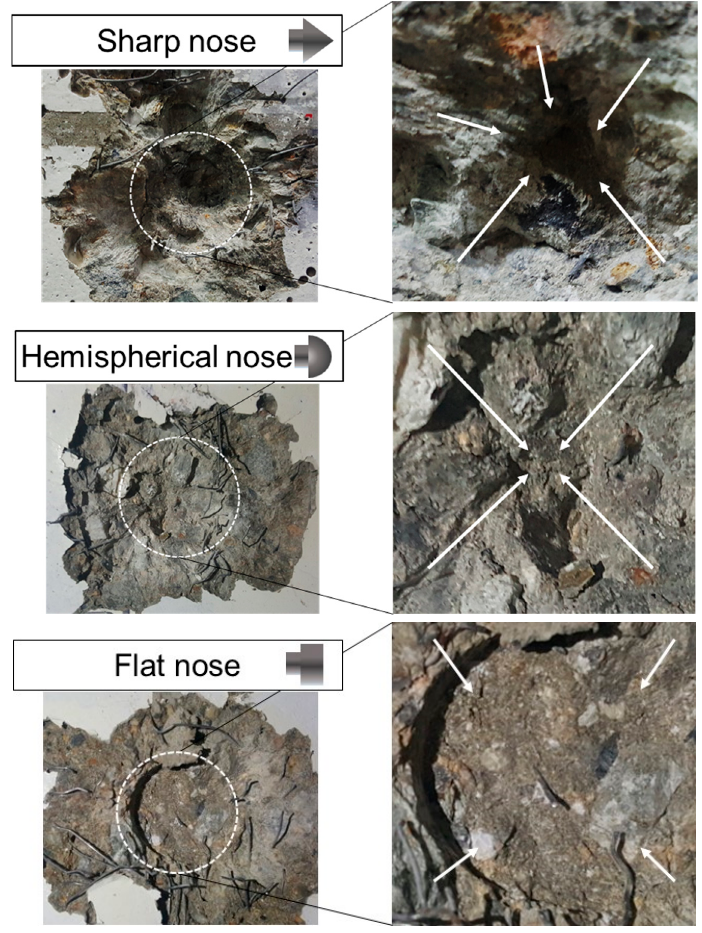
Figure 8. Impact fracture on the front face.